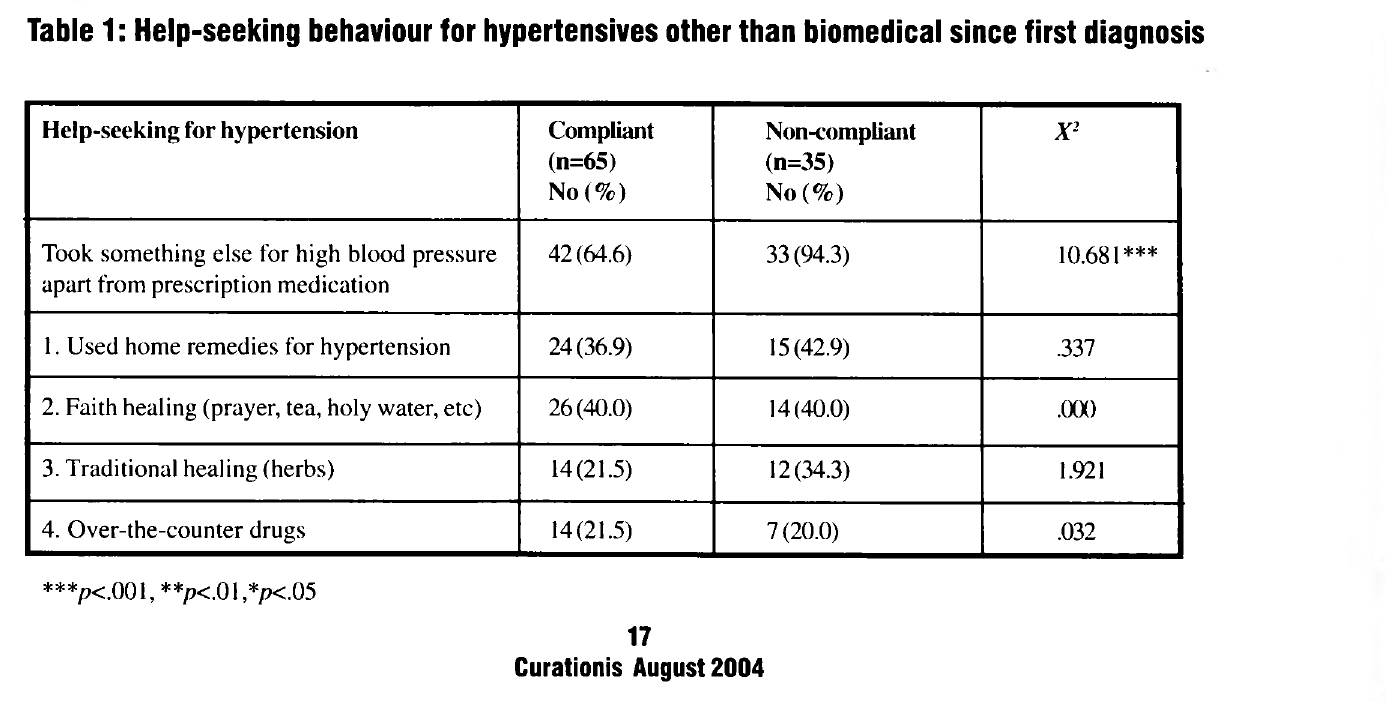
Table 1: Help-seeking behaviour for hypertensives other than biomedical since first diagnosis